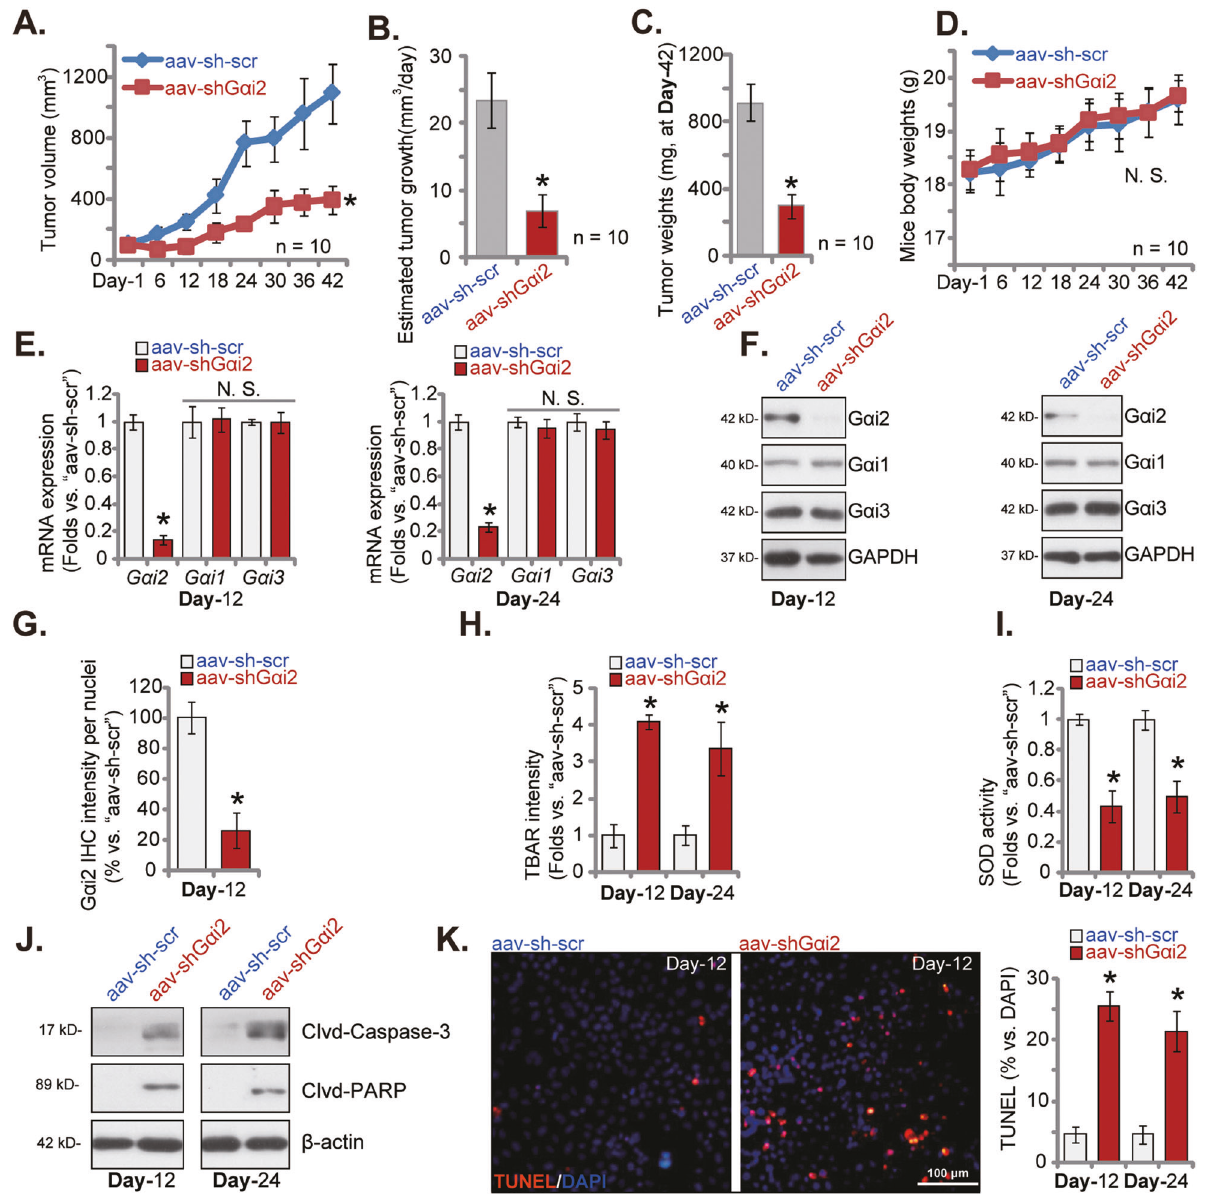
Fig. 8 G α i2 silencing suppresses pHCC1 cell xenograft growth in nude mice. The nude mice bearing subcutaneous pHCC1 xenografts were subject to intratumoral injection of shG α i2-s1-expressing adeno-associated virus ( “ aav-shG α i2 ” ) or the scramble control shRNA adeno- associated virus ( “ aav-sh-scr ” ), and ten mice in each group ( n = 10). Virus was injected every 48 h for fi ve rounds. The pHCC1 cell xenografts ’ volumes ( A ) and animal body weights ( D ) were recorded every six days. The estimated daily tumor growth (in mm 3 per day) was calculated ( B ). At Day-42, all pHCC1 xenografts were carefully isolated and weighted ( C ). The listed pHCC1 xenografts were homogenized, and listed genes and proteins in the tissue lysates tested ( E , F and J ). The TBAR intensity ( H ) and the SOD activity ( I ) in xenograft tissue lysates were examined. The relative G α i2 IHC quanti fi cation results in pHCC1 xenograft slides were shown ( G ). The representative TUNEL fl uorescence images in the described pHCC1 xenograft slides were shown ( K ). The data were presented as mean ± standard deviation (SD). * P < 0.05 versus “ aav-sh-scr ” group. “ N. S. ” stands for non-statistical difference ( P > 0.05). Scale bar = 100 μ G α i2 overexpression in HCC tissues correlates with poor prognosis signi fi cantly slowed in nude mice. Thus, targeting G α i2 could be a promising molecularly targeted therapy for HCC. of the patients. G α i2 mRNA and protein expression is also elevated A fi ne strategy to inhibit HCC cell growth and to activate in local HCC tissues and different human HCC cells. In primary HCC apoptosis is through inducing ROS production and oxidative cells and immortalized HepG2 cells, G α i2 shRNA or KO largely stress. Metabolic activation of PCK1 (phosphoenolpyruvate suppressed cell growth and migration, while inducing cell cycle carboxykinase 1) promoted energy crisis, oxidative stress and arrest and caspase-apoptosis activation. Depletion of G α i2 apoptosis in HCC cells and inhibited HCC cell growth in vitro and however failed to signi fi cantly inhibit viability and proliferation in vivo [48]. Wang et al. revealed that CDCA2 (cell division cycle of normal hepatocytes. In vivo, intratumoral injection of associated 2) promoted HCC cell growth and inhibited apoptosis G α i2 shRNA AAV largely hindered growth of pHCC1 xenografts possibly by activating NRF2 signaling axis and inhibited oxidative in nude mice. Moreover, G α i2-KO pHCC1 xenografts growth was